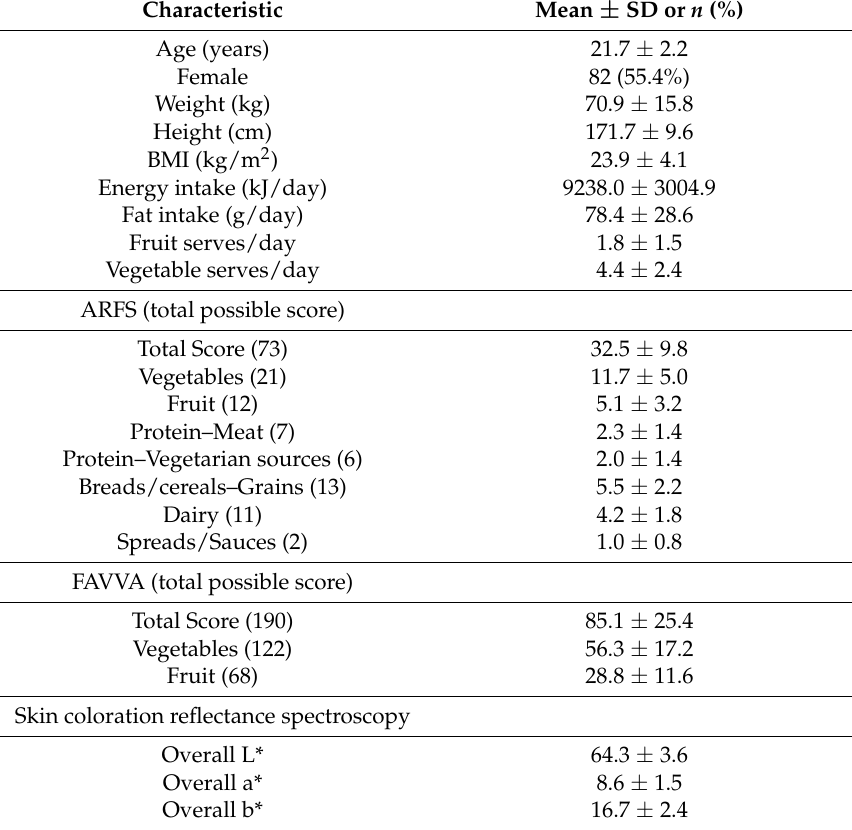
Table 1. Characteristics of participants ( n =